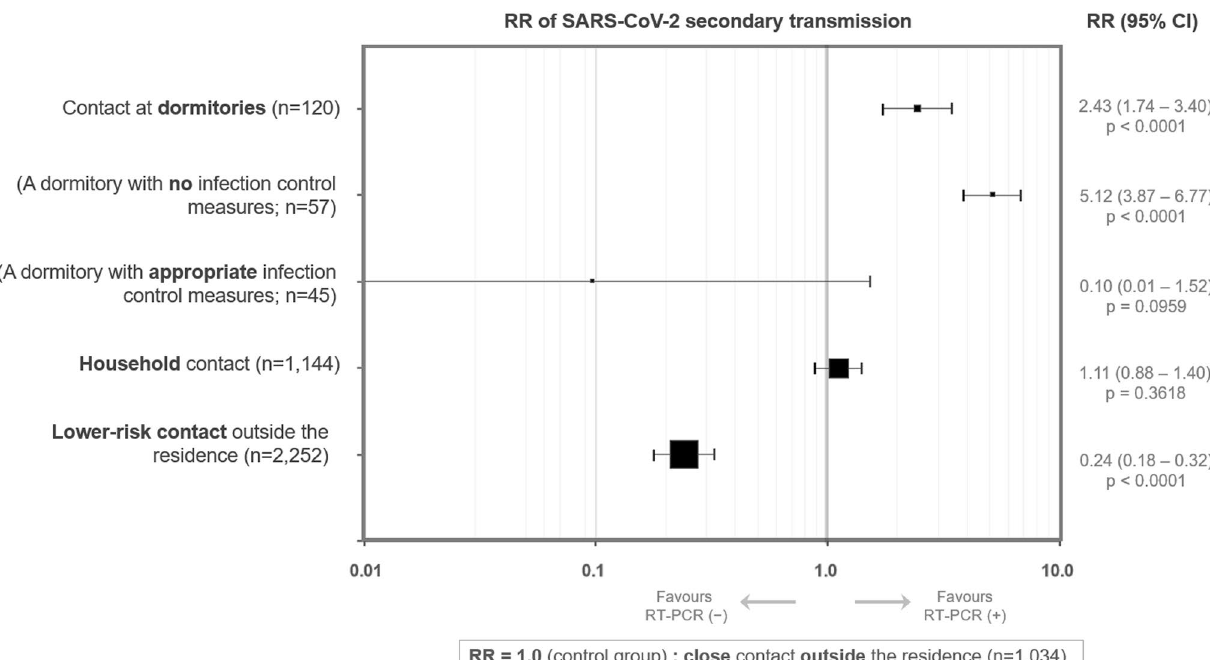
Figure 3. Relative risks of acquiring the COVID-19 infection by place of contact with COVID-19 patients. The figure shows subgroup-specific risk ratios (RR) for subjects in different groups divided by the places and levels of recent contact history with COVID-19 patients. The crude RR for each subgroup is plotted as a black square, and the size of each plot is proportional to the number of subjects in each subgroup. Error bars represent 95% confidence intervals of the RR. Individuals with recent close contact outside their residences (n = 1034) were considered as the control group, corresponding to an RR value of 1.0 (the solid vertical line). The values of RR above 1.0 indicate that people in each group are more likely to have a positive SARS-CoV-2 RT-PCR test result. An RR value of < 1.0 indicates a lower RT-PCR test positivity rate. The calculated RR are plotted on a logarithmic scale. COVID-19, coronavirus disease; RR, risk ratios; RT-PCR, reverse transcription polymerase chain reaction; SARS-CoV-2, severe acute respiratory syndrome coronavirus